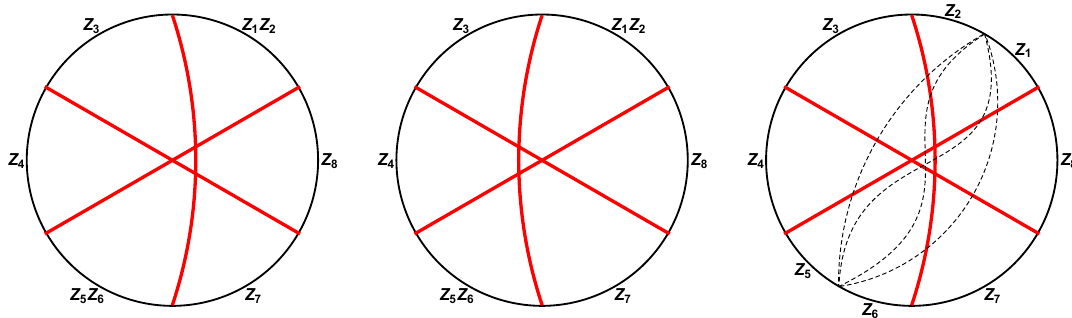
Figure 5 . Left and center: the two auxiliary geometries for three mutually intersecting geodesics. Right: eight auxiliary geometries can be chosen for four mutually intersecting geodesics; here we draw the four possible ways to pass the fourth geodesic given the three-geodesic choice on the